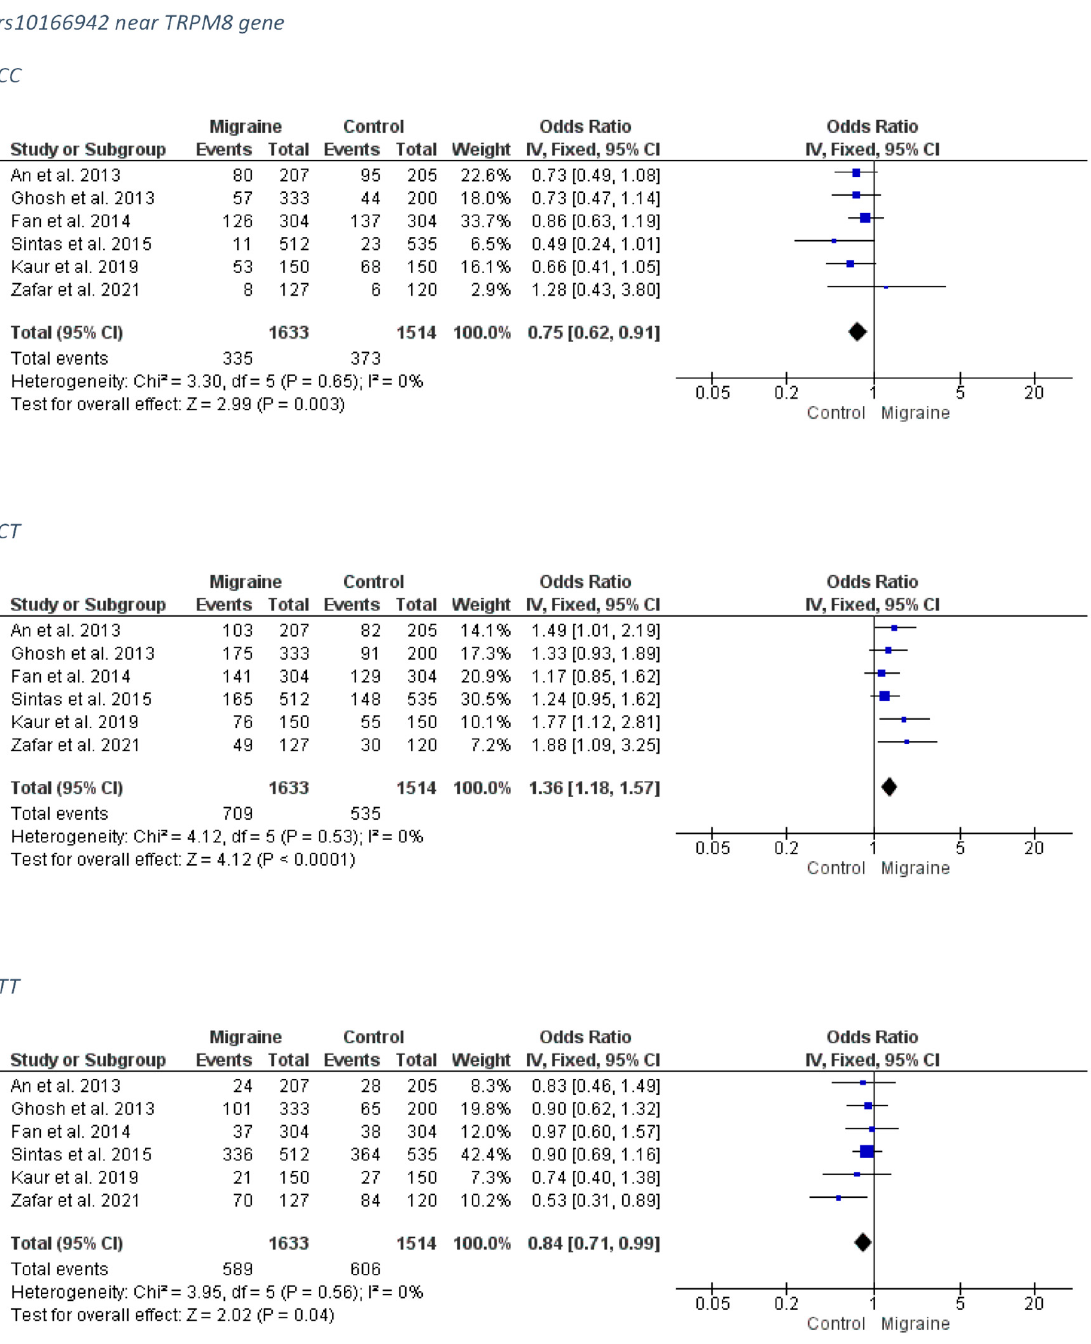
Figure 4. The forest plots presenting the results from meta-analysis of the rs10166942 and overall migraine group .